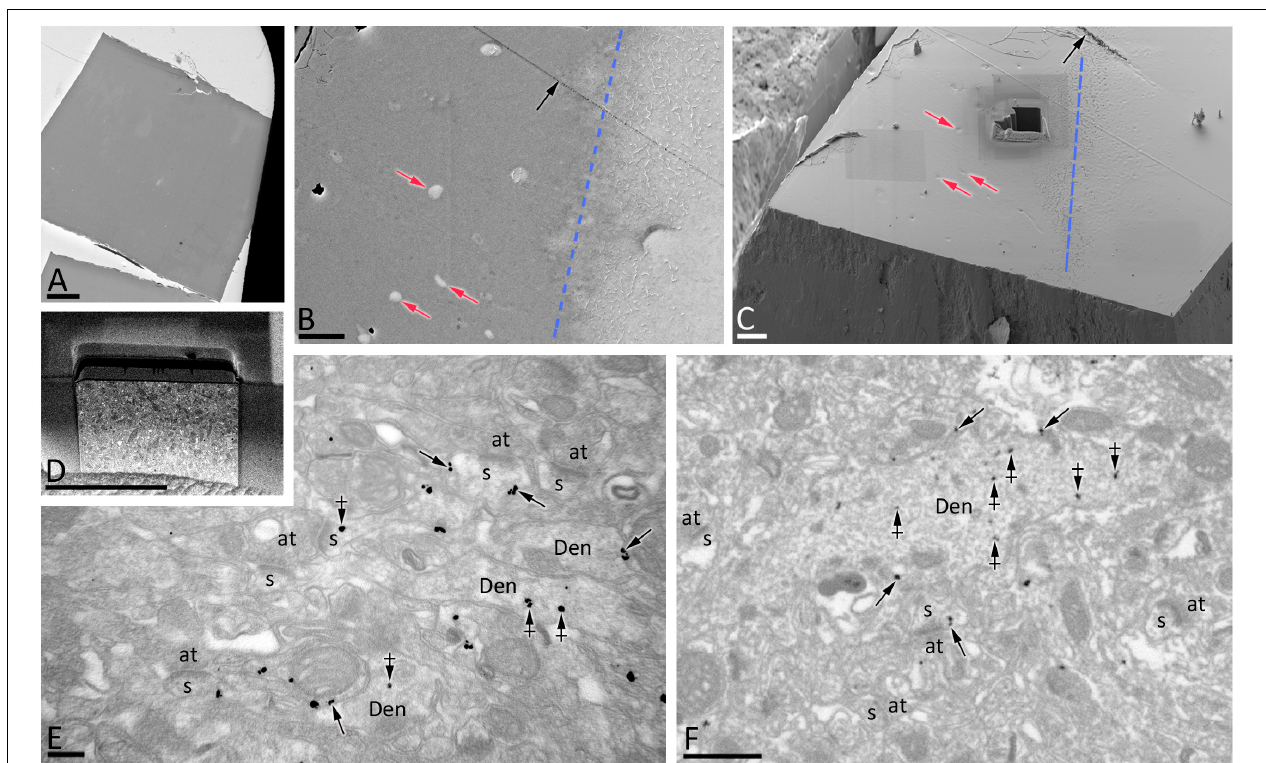
FIGURE 1 | FIB/SEM microscopy combined with pre-embedding immunogold allows high-resolution 3D mapping of SK2 in neurons. (A) TEM ultrathin image of the resin block surface allows the visualization of tissue-resin interface to select optimal areas of SK2 immunolabelling. (B,C) SEM image of the block surface, revealing conserved landmarks (red arrows for blood vessels, black arrow for a knife mark), allows the selection of the starting plane for serial image acquisition close to the tissue-resin interface (blue line). A trench has been milled close to the tissue-resin interface (blue line) to gain access to the region of interest. (D) Low magnification SEM backscattered electron image showing a milled surface of the trench face during one of the milling-imaging cycles. (E) TEM ultrathin image showing immunolabelling for SK2 in the plasma membrane (arrows) and intracellular sites (crossed arrows) of spines (s) and shafts (Den) in the stratum radiatum . Several axon terminals (at) are also visible. (F) FIB/SEM image of the same area and block to that illustrated in panel (E) showing SK2 immunolabelling in the plasma membrane (arrows) and intracellular sites (crossed arrows) of spines (s) and shafts (Den). Some axon terminals have also been labeled (at). Scale bars: (A) 100 µ m; (B–D) 20 µ m; (E) 200 nm; (F) 1 µ